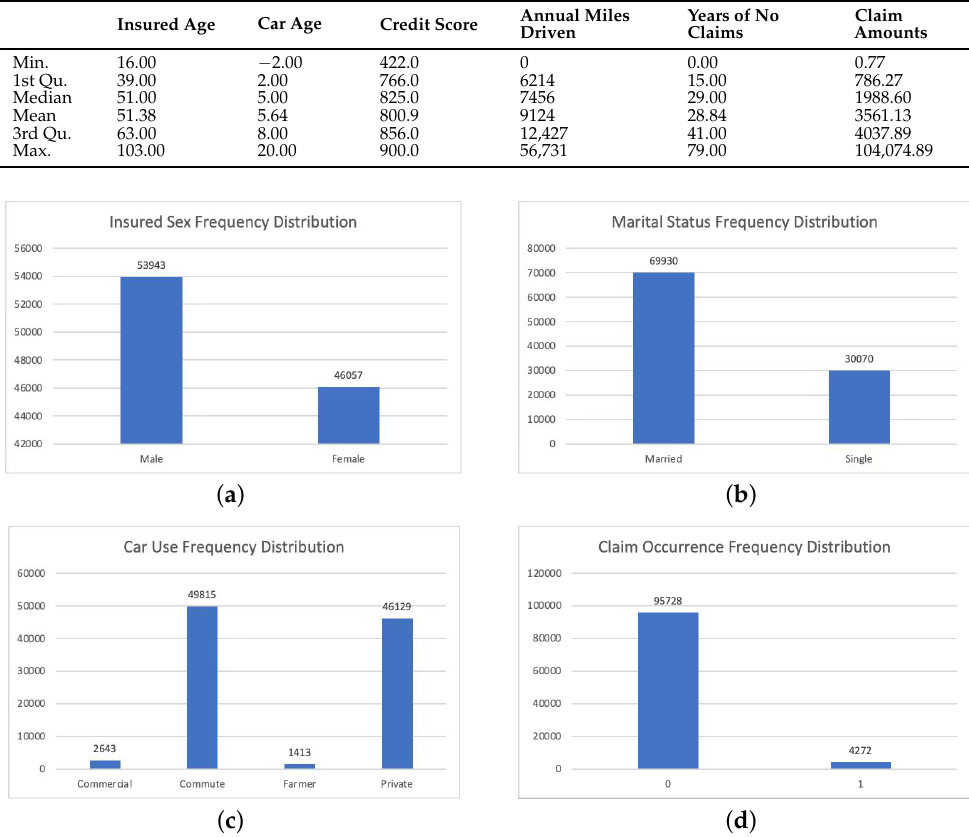
Table 2. Five number summary statistics (i.e., Minimum, 1st Quartile, Median, 3rd Quartile, and Maximum) and the mean value for numerical variables used in this work including the response variable Claim amounts where zero losses are excluded. Note that the minimum value − 2 for Car Age is due to the fact that buying a newer model can occur up to two years in advance.